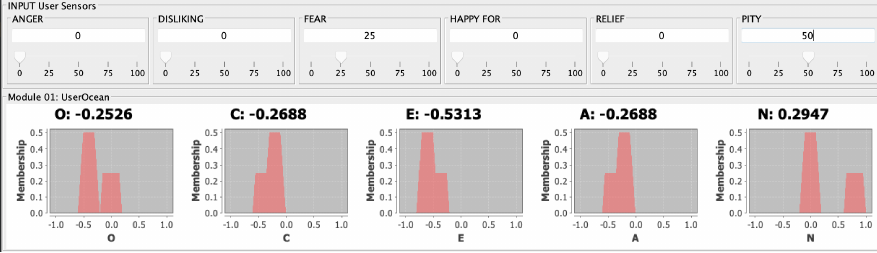
Figure 7. Deffuzification